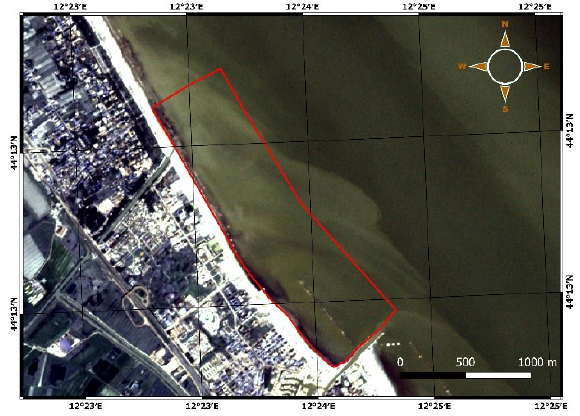
Figure 1. Area of analysis